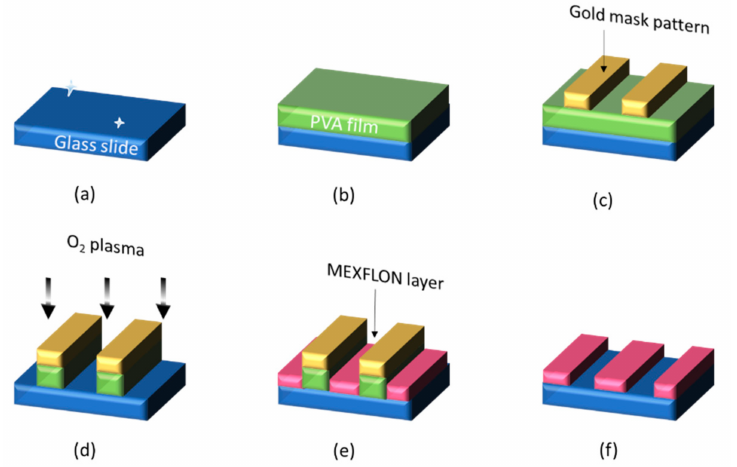
Figure 4. Fabrication process for nanosteps using IM material via vacuum deposition and lift-off: ( a ) cleaning; ( b ) spin-coating; ( c ) metal mask by nTP; ( d ) etching; ( e ) deposition; ( f ) lift-off by